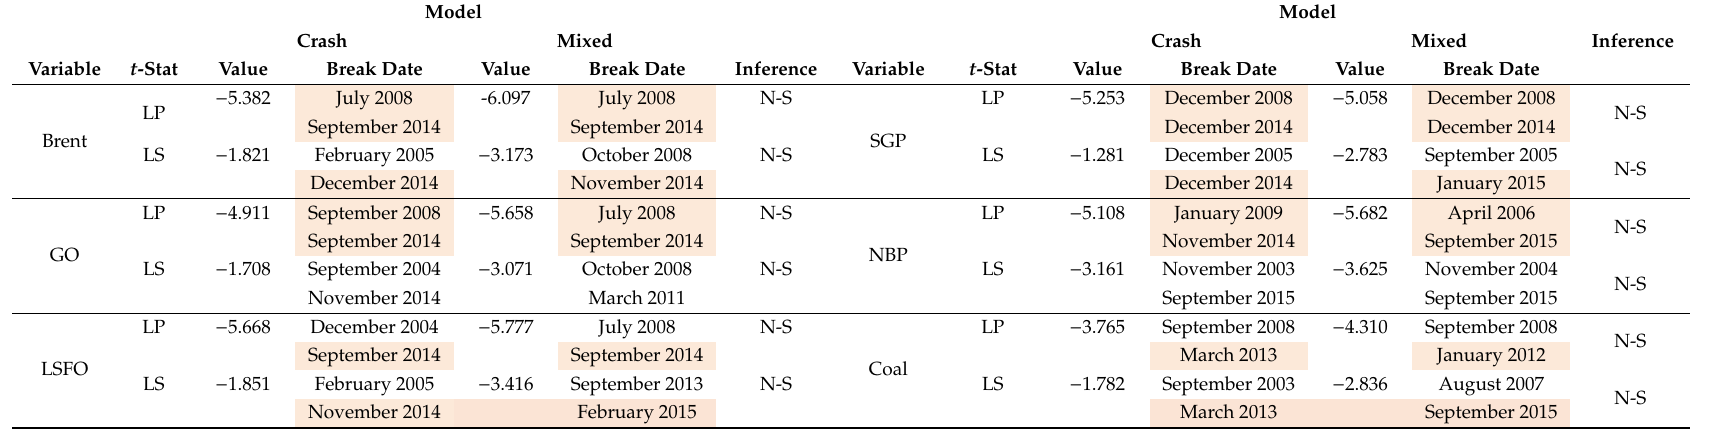
Table 4. Two-break unit root test